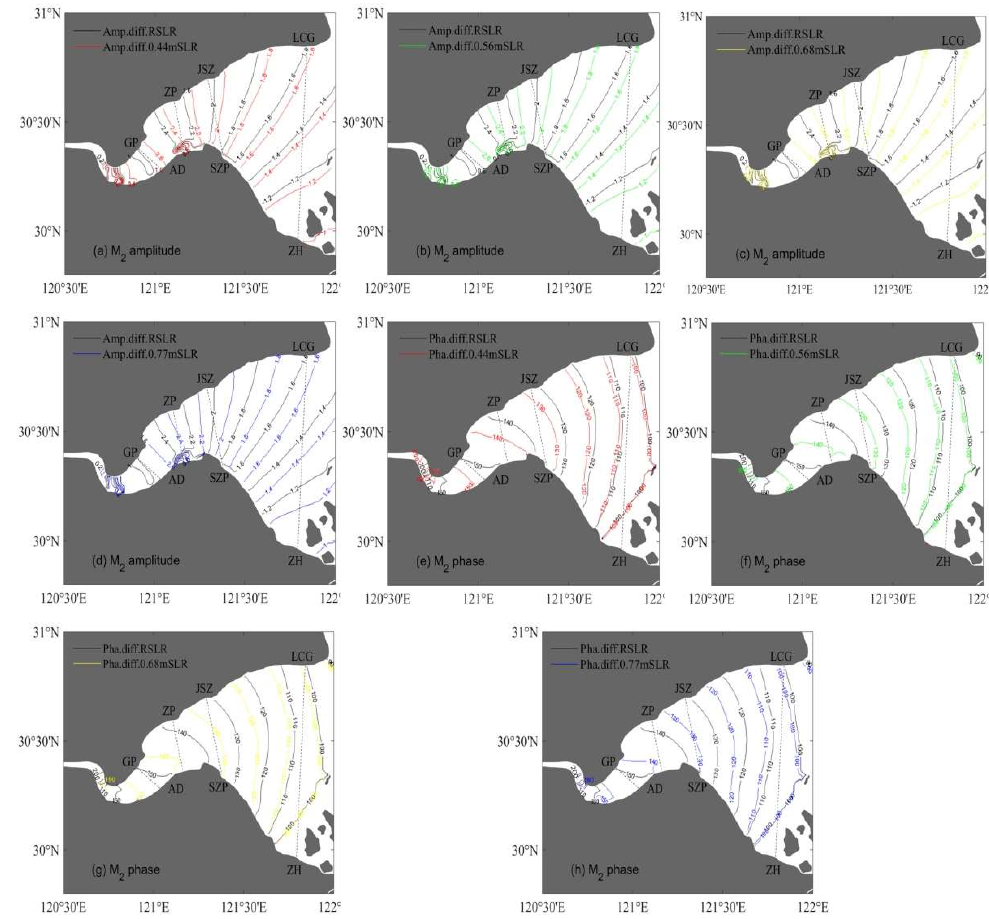
Figure 7. Differences in the ( a – d ) M 2 amplitude and ( e – h ) M 2 phase between the SLR scenarios and RSLR scenario.